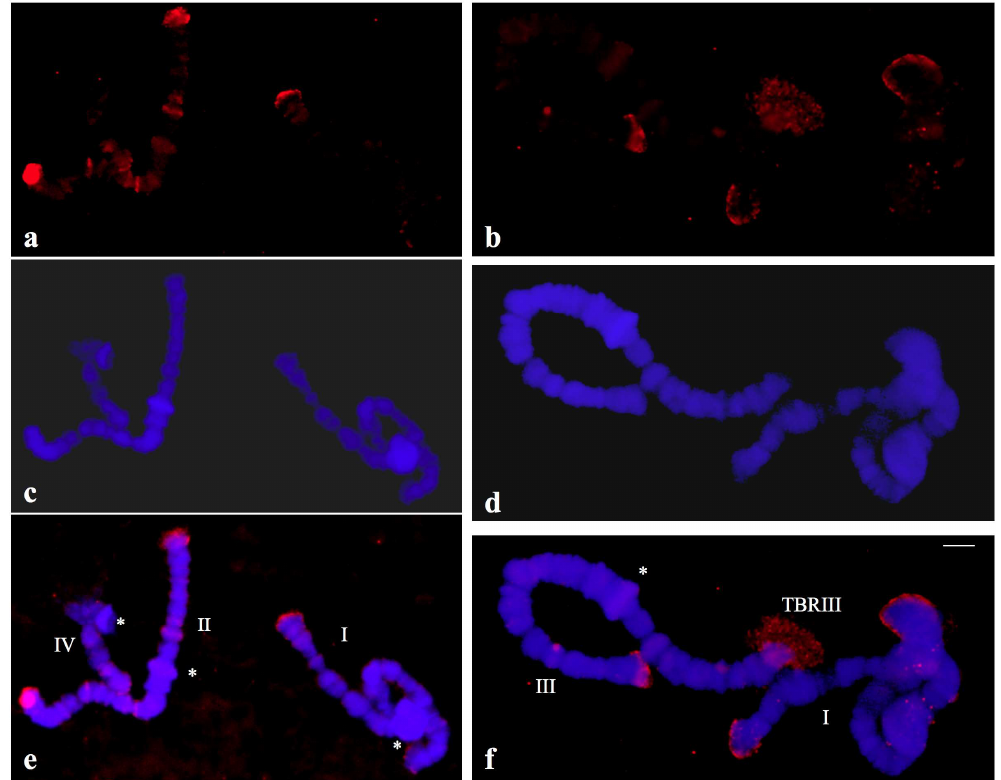
Figure 8. ( a , b ) Localization of the probe (red signal) synthesized with DNA from a microdissected telomeric pu ff (TBRIII) of Chironomus riparius in polytene chromosomes of C. riparius. ( c , d ) the same chromosomes stained with DAPI and ( e , f ) the merged hybridization and DAPI signals. The asterisks indicate the centromeric regions of the chromosomes identified individually (I, II, III,